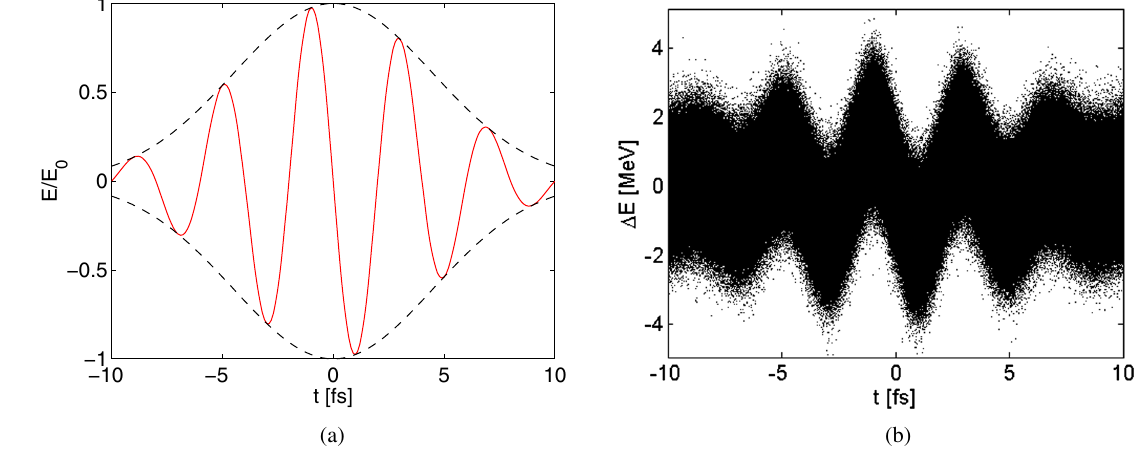
FIG. 4. (a) Normalized electric field of the laser pulse. (b) Energy change of the electron beam induced by the laser pulse.